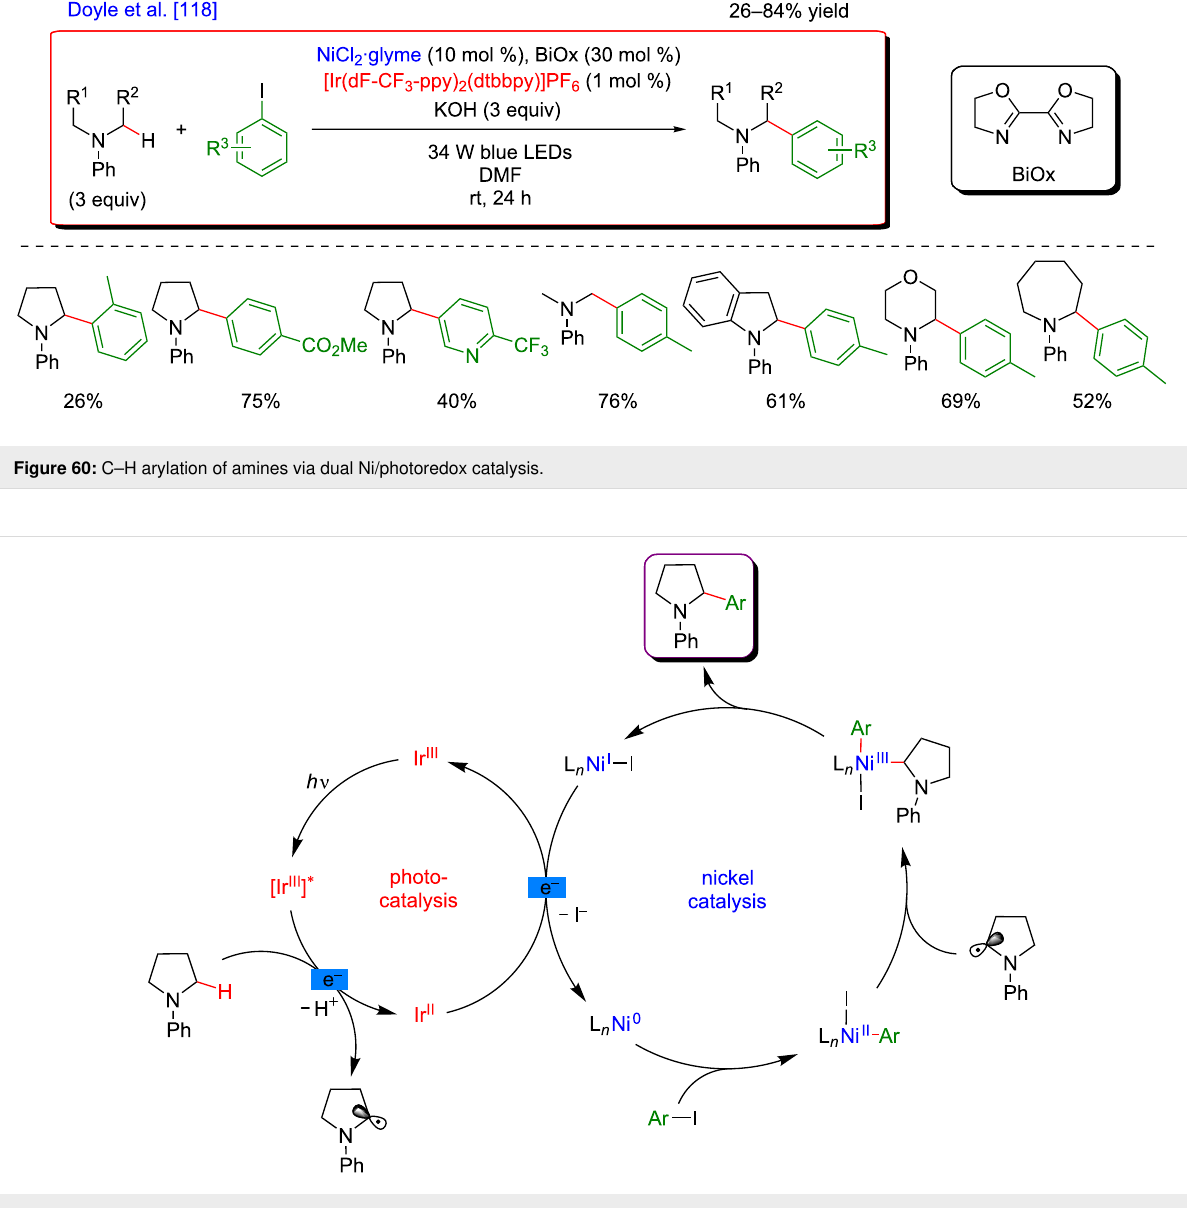
Figure 61: Proposed mechanism for the C–H arylation of amines via dual Ni/photoredox